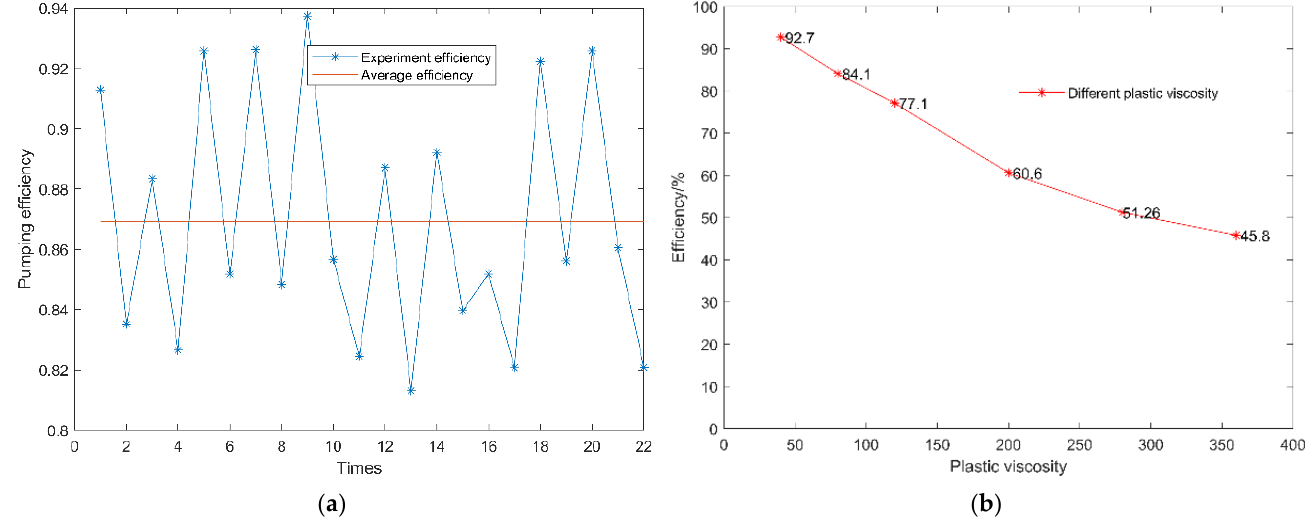
Figure 18. Experimental concrete pumping efficiency. ( a ) Simulation average efficiency. ( b ) Efficiency trends at different plastic viscosities.